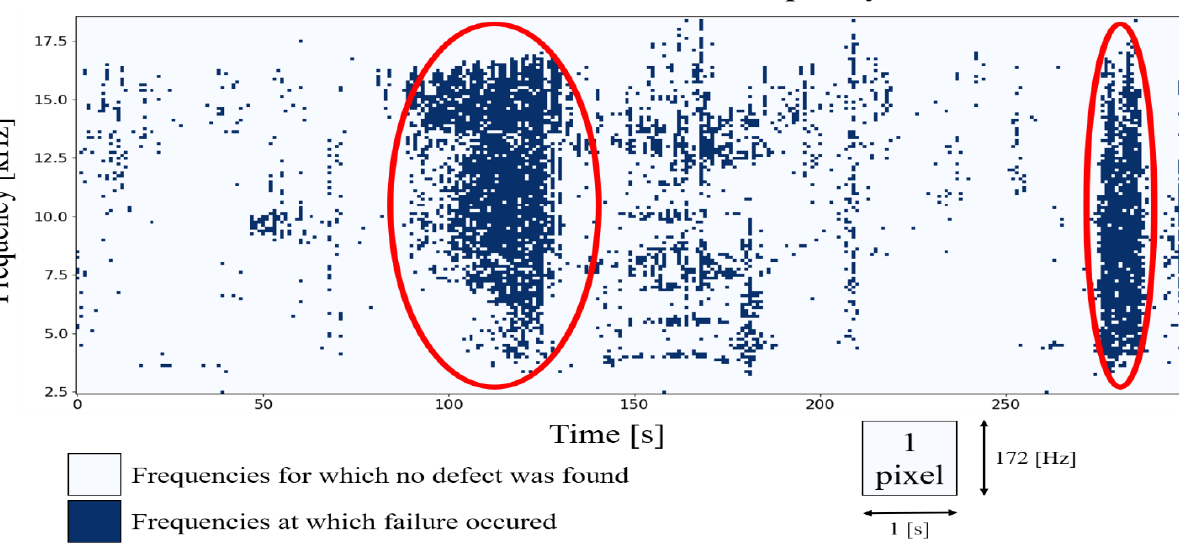
Figure 8. Detection results over the entire signal length. Two visible failures have been marked with red ellipses.